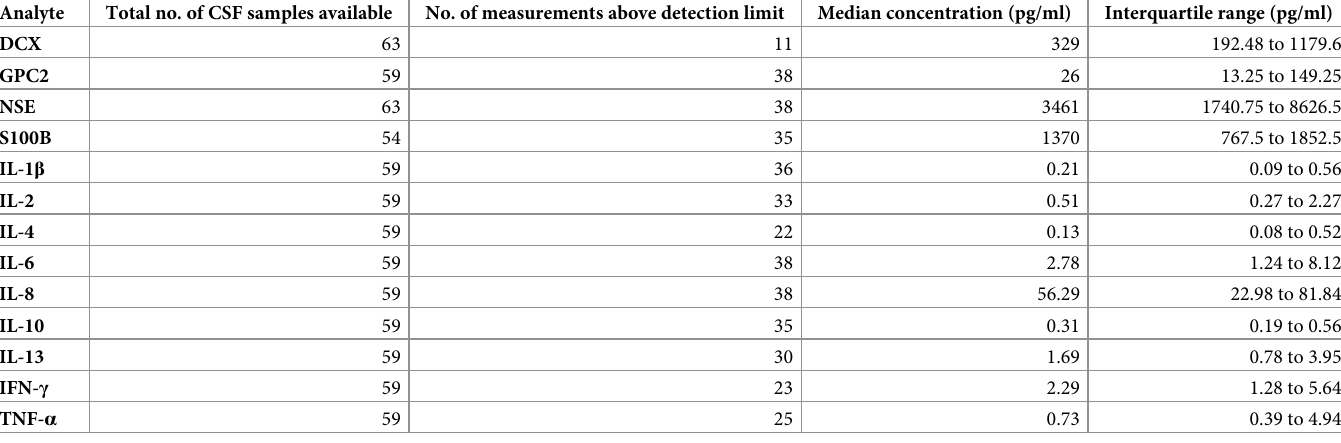
Table 2. Data availability of variables and summary statistics at the 1 st measurements. Analyte Total no. of CSF samples